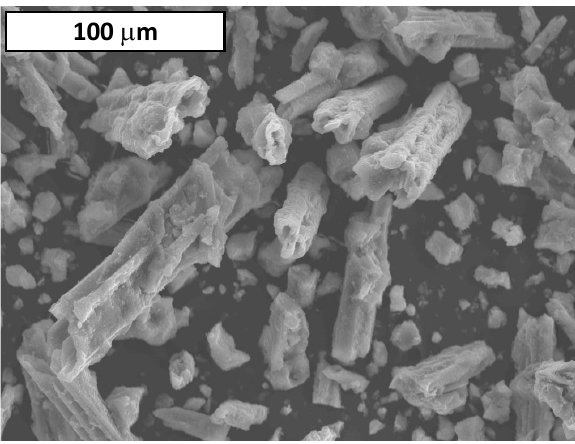
Figure 5: Struvite crystals produced from phosphorus mineral fertilizers industry wastewater in a continuous DT MSMPR crystallizer. Process parameters: T 298 K, pH 9, τ 900 s, PO 43– :Mg 2+ :NH 4+ = 1:1.2:1